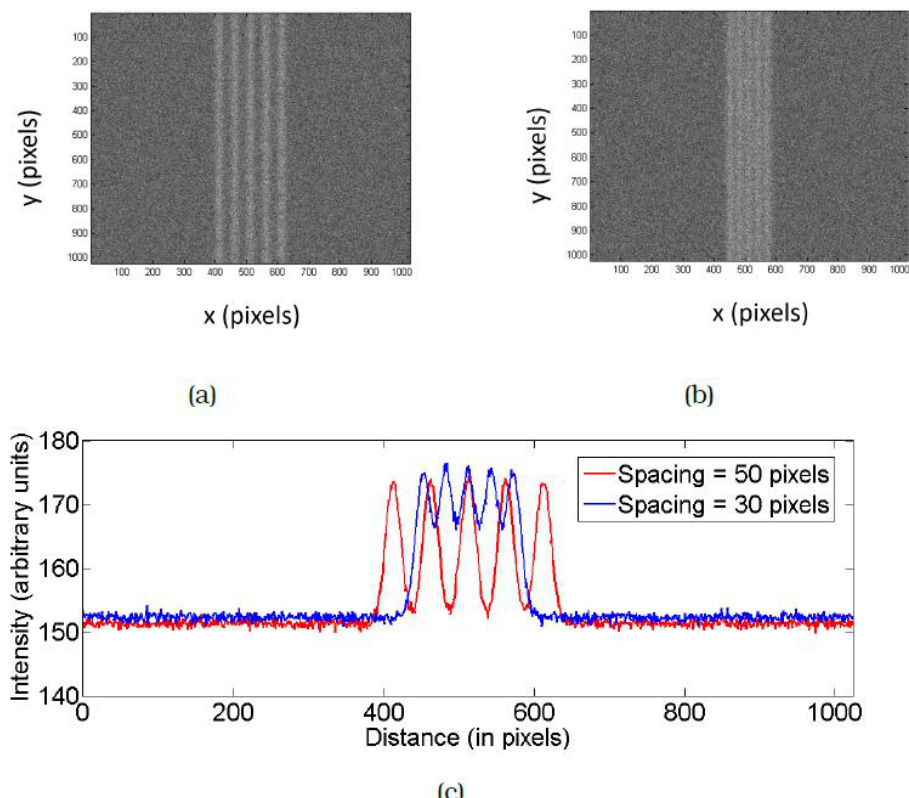
Figure 2. Simulated secondary electron (SE) images of dense FEBID lines with Gaussian profiles. The centre to centre spacing between the lines is ( a ) 50 pixels and ( b ) 30 pixels. ( c ) Comparison of the integrated intensity profile of the two images, clearly demonstrating the increase in amount of material deposited in between the lines as the spacing decreases.